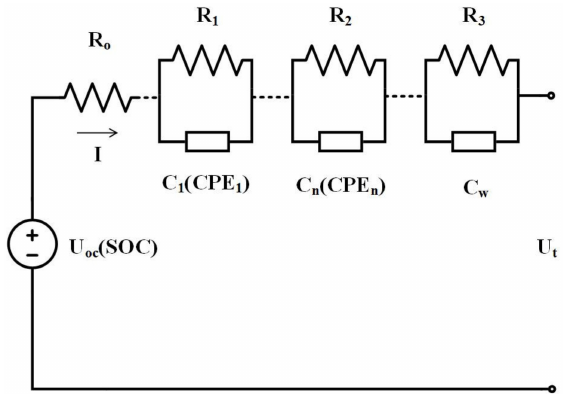
Figure 17. n-RCW integral and fractional order models